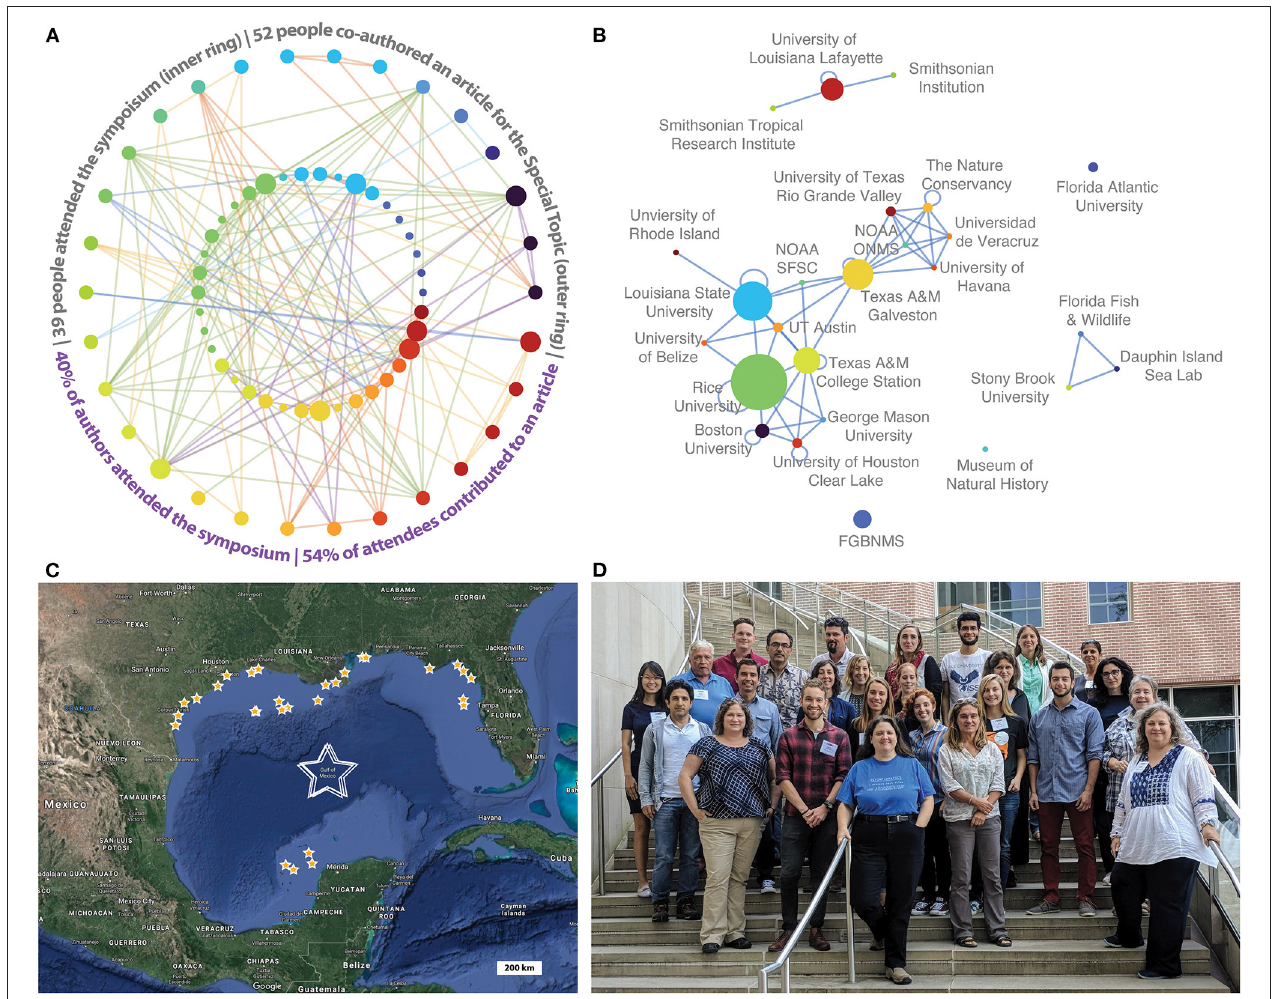
FIGURE 1 | Summary of individual and institutional collaborations in the “Gulf of Mexico (GoM) Reefs: Past, Present and Future" Special Topic. (A) Collaboration network in which nodes are individuals shaded by institutional affiliation (key in B ). Node size scales with the number of papers authored in the Special Topic. Connecting lines depict paper collaborations in the Special Topic, and are shaded by manuscript. The inner circle of nodes are individuals who attended the GoM Reefs Symposium. (B) The same network, with collaborations accumulated by institution (same color scheme as A ). This graph uses a force-directed layout. (C) Google Earth map depicting the Gulf of Mexico, indicating the study locations (filled stars) of papers in this Special Topic. The three open stars at the center of the GoM represent papers that span the entire gulf. (D) Subset of the participants attending the GoM Reefs Symposium held at Rice University (Houston, TX USA) on October 10-11,